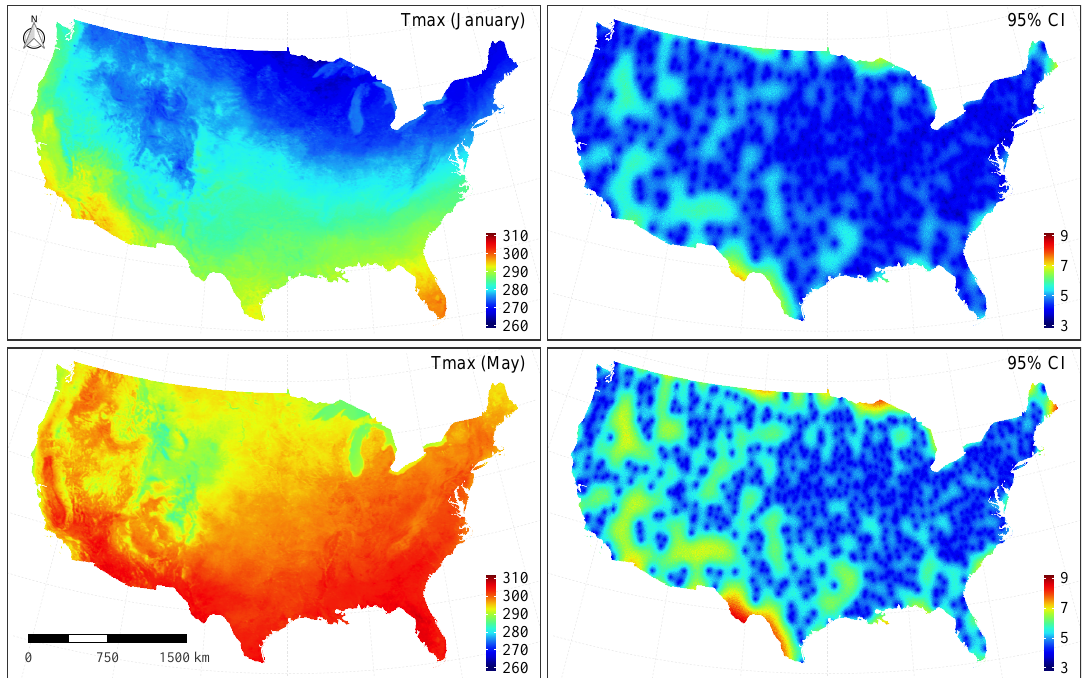
Figure 10. Estimation of Tmax in January and May: ( top row ) maps of estimated Tmax and its 95% credible intervals (CI) in January. ( bottom row ) Maps of estimated Tmax and its 95% CI in